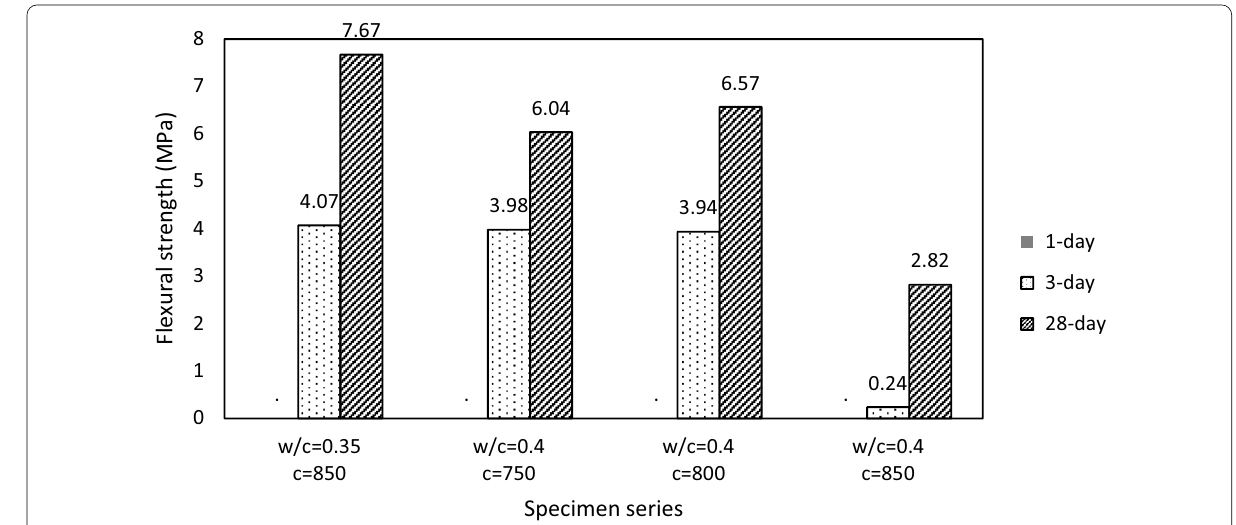
Fig. 11 Flexural strength of mortars at three